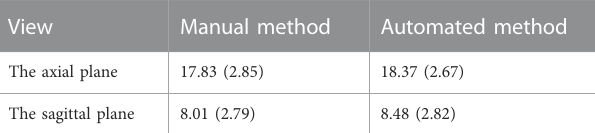
TABLE 2 The mean values (standard deviation) of the Exophthalmometric values betweenthe results measuredbythe proposedautomated method and the manually measured results.